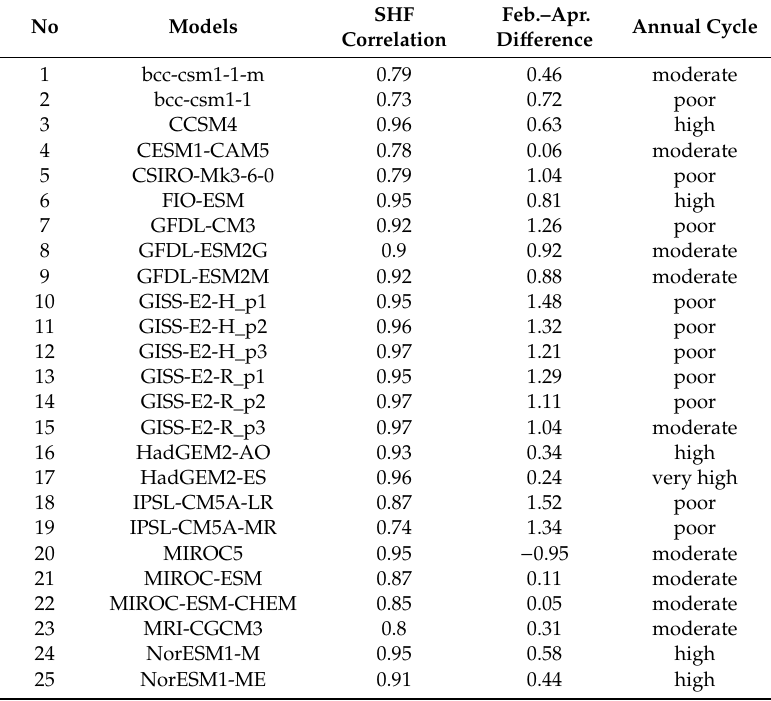
Table A2. Evaluation of NW-Ethiopia highlands CMIP5 model sensible heat flux (SHF) with ECMWF reanalysis 1981–2010. Correlation of mean annual cycle, Feb.–Apr. seasonal di ff erence between observation and model (mm / day), and phase / amplitude ‘fit’ of annual